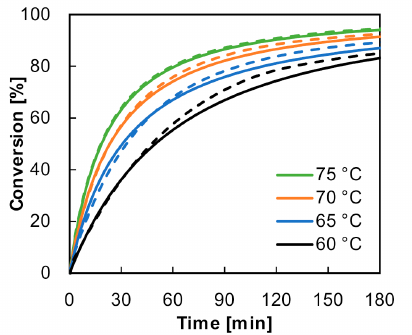
Figure 11. Comparison of reaction conversion curves of acrylic acid polymerisations in isopropyl alcohol (150 g/L, 1.0 mol% AIBN) acquired from Raman spectroscopy (solid lines) and reaction calorimetry (dashed